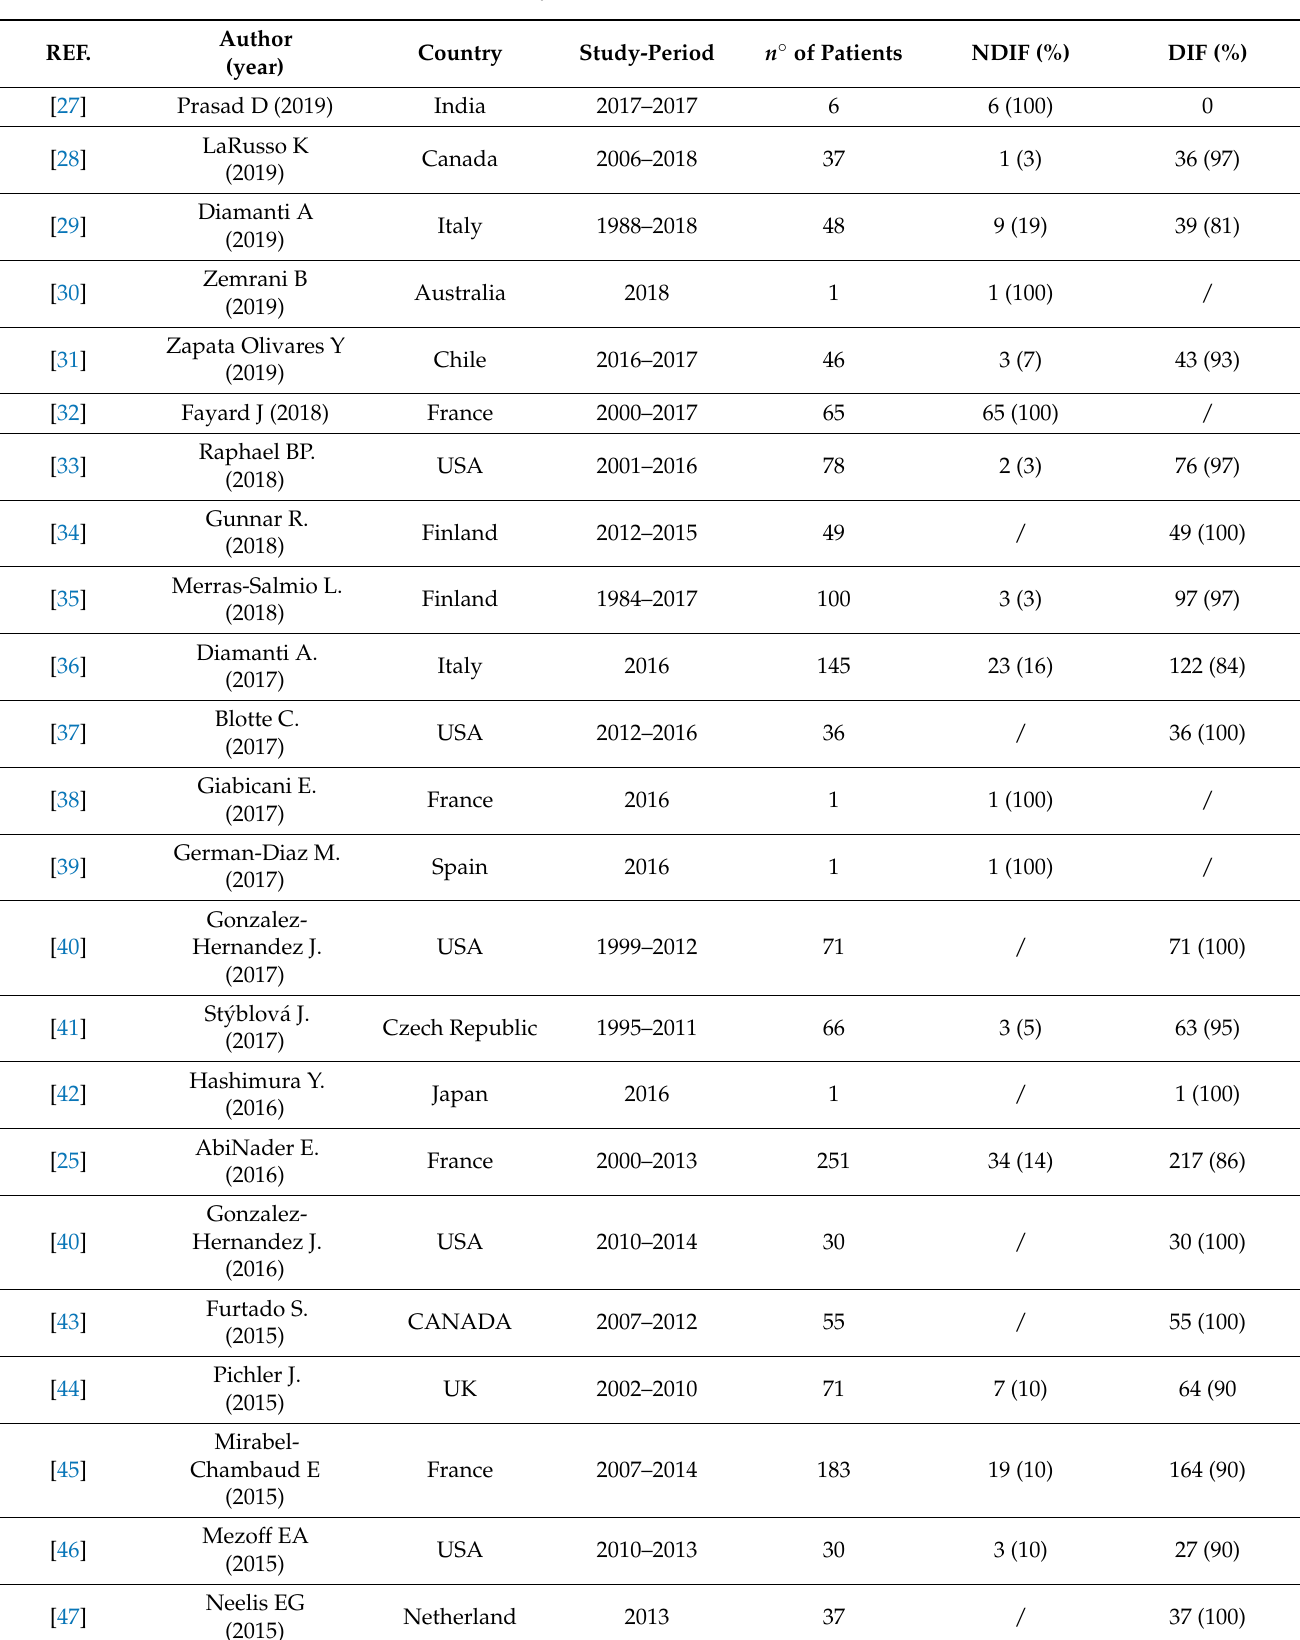
Table 1. Summary of the studies selected for the